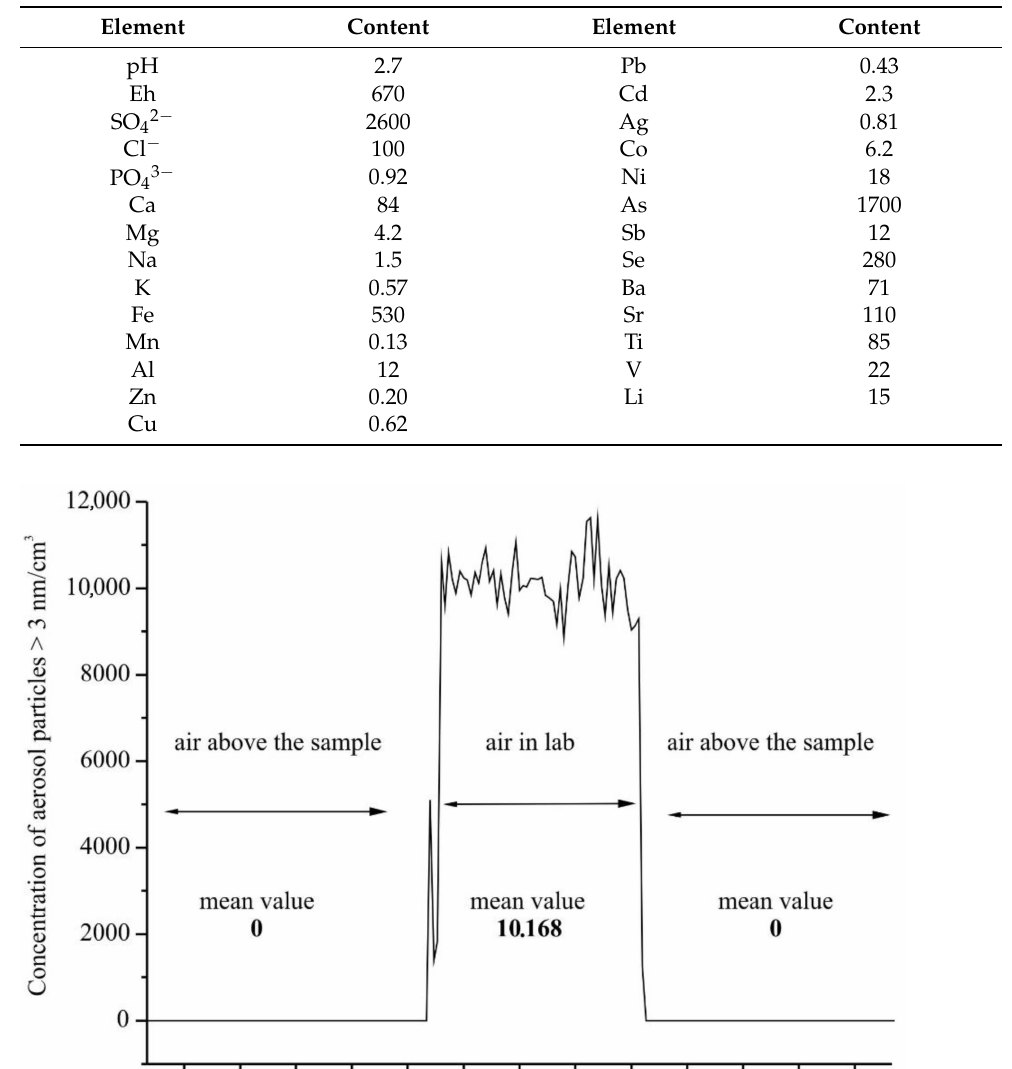
Table 3. Physical-chemical parameters (redox potential Eh in mV) and composition of the aqueous extract from the sample (SO 42 − –Pb in mg/L, Cd–Li in µ g/L).